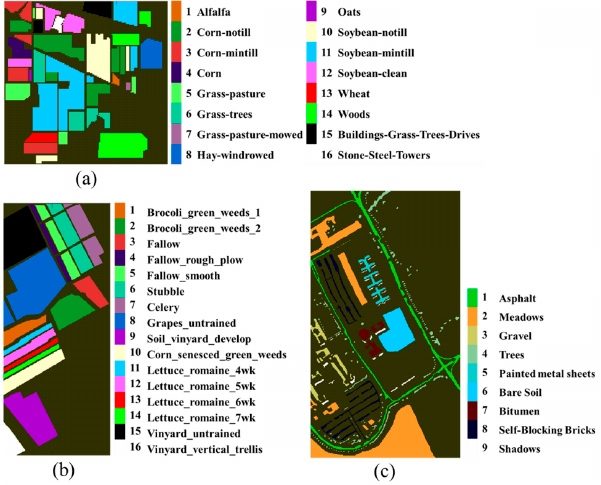
Figure 4. Ground truth of datasets in Group II. ( a ) Ground truth of the truncated Salinas (SAL) image. ( b ) Ground truth of the IND PINE image. ( c ) Ground truth of the Pavia University (PAV) image.